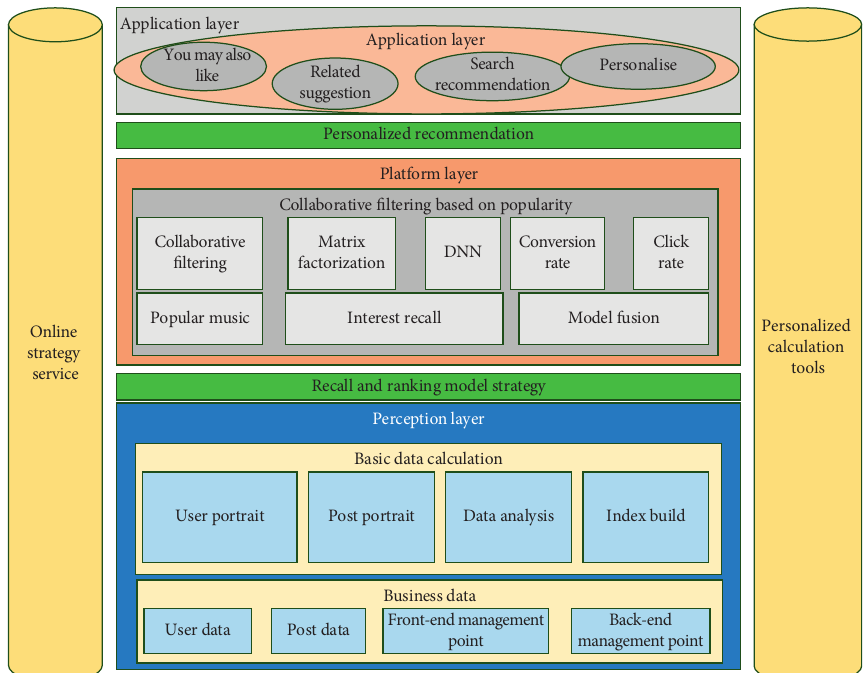
Figure 1: Schematic diagram of the framework of an improved collaborative filtering personalized music recommendation system.